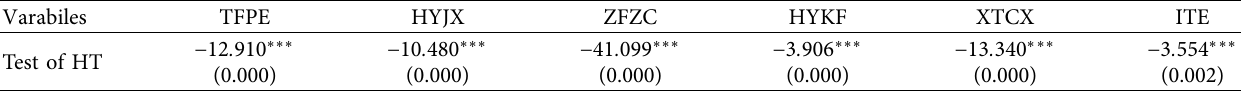
Table 4: Test of units.